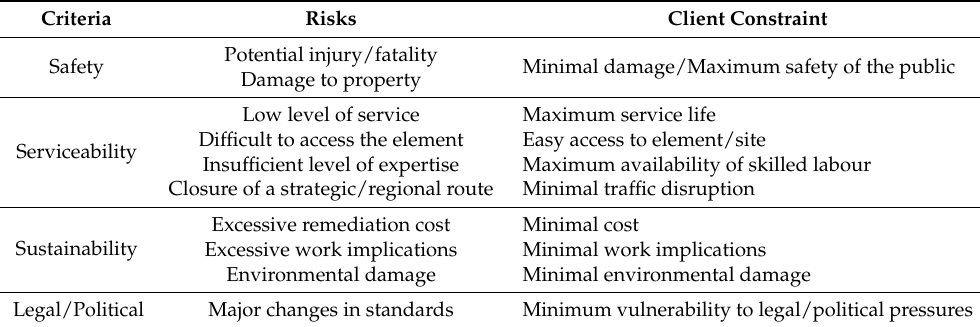
Table 3. Major Risks and Client Constraints for Bridge